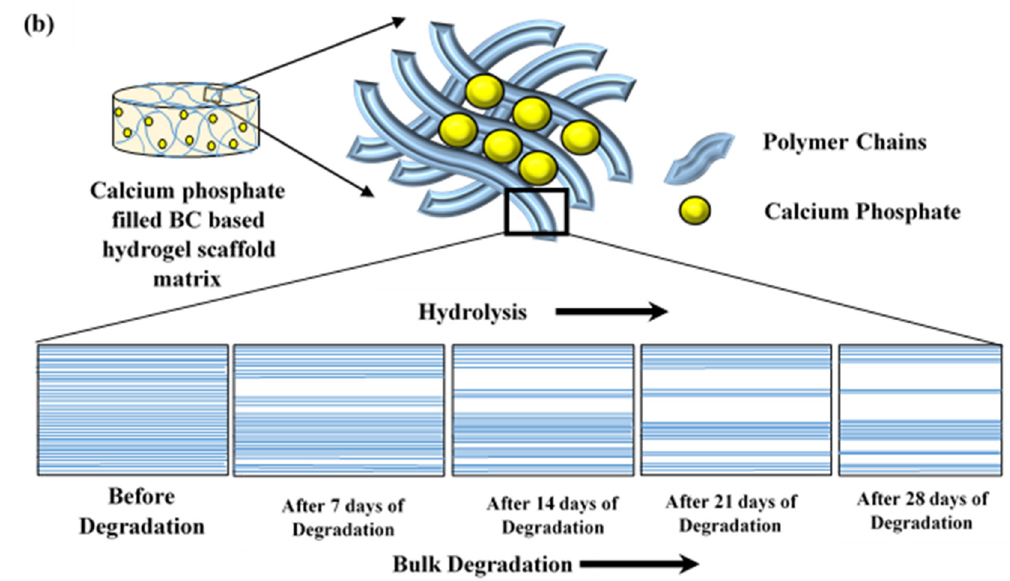
Figure 3. Hydrolytic degradation study of calcium phosphate filled BC based hydrogel scaffolds (i.e., 20:80_CaP/BC-PVP, 40:60_CaP/BC-PVP, and 50:50_CaP/BC-PVP). ( a ) Weight Loss (%) profiles of the scaffolds, Asterisks (***P < 0.0001) indicate the level of significance, (Statistical analysis performed through mean ± standard error of the mean and suitable post-hoc (Bonferonni test/Dunnet) test was